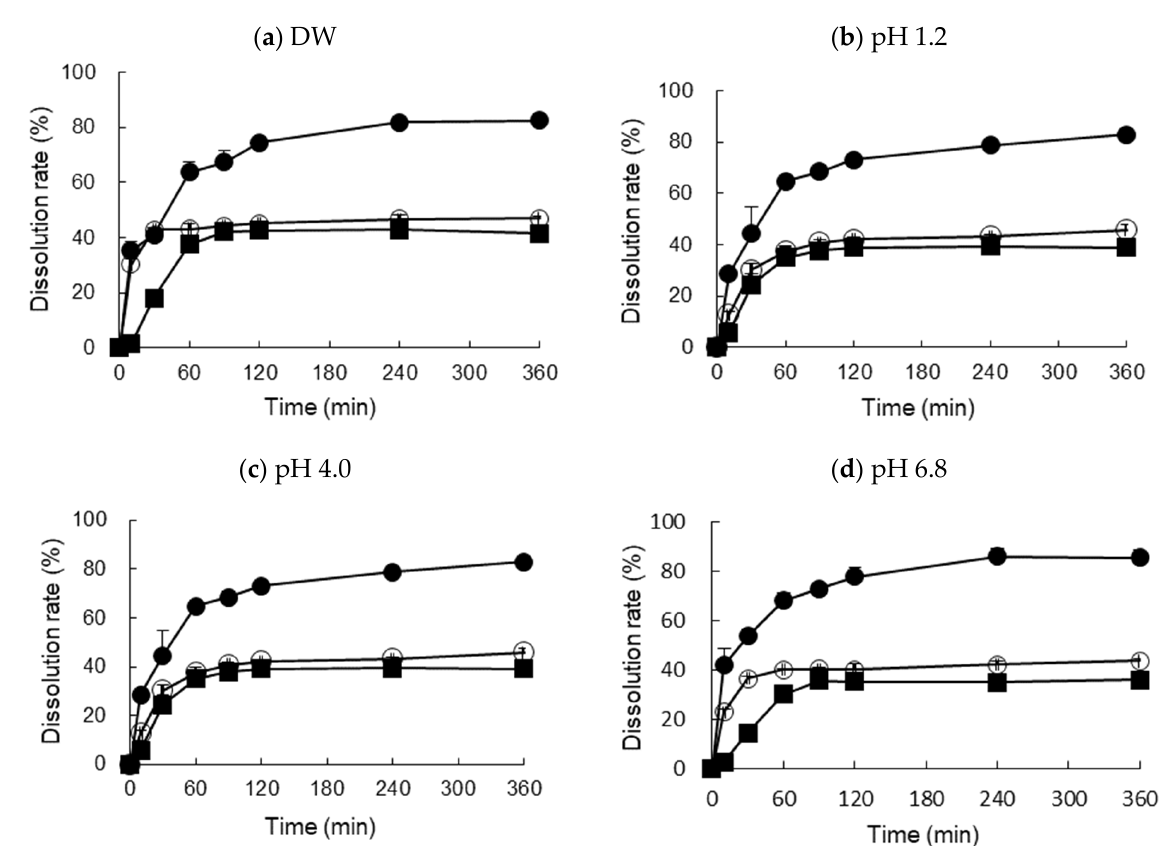
Figure 8. Dissolution profiles of optimized RXB-ASD, RXB powder, and commercial tablet (Xarelto 20 mg) in four different media ( n = 3, means ± SD). (Key: ● : Optimized RXB-ASD, ○ : Xarelto ® 20 mg, ■ : RXB powder).